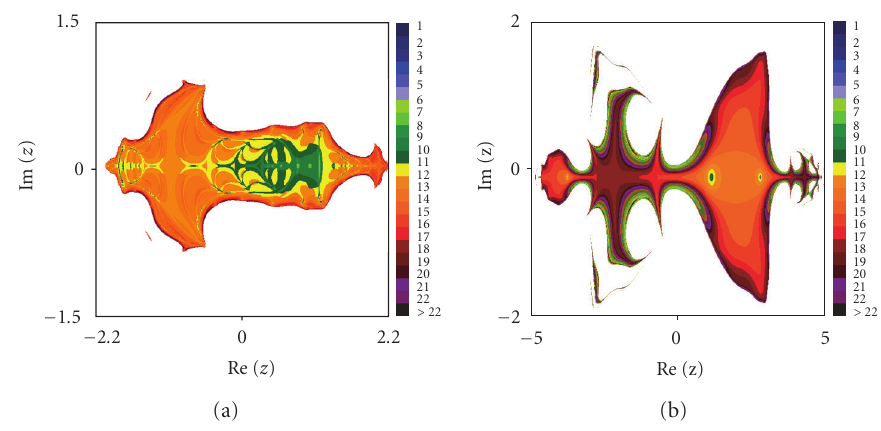
Figure 4.3. Basins of attraction of z 1 using (4.6). (a) With PR method and λ = 0 . 4. (b) With FR method and λ = 0 .